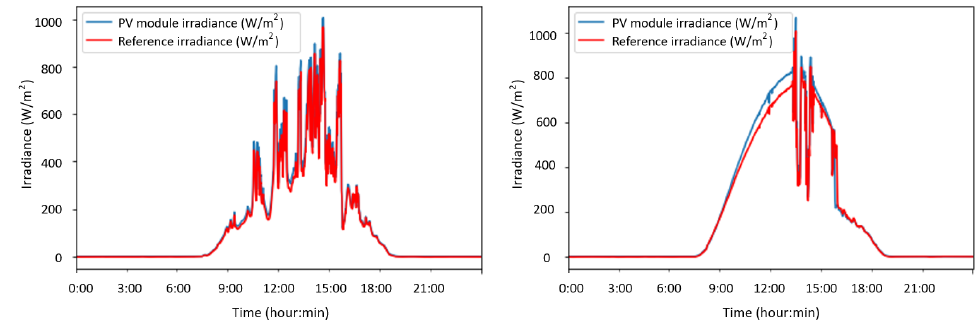
Figure 11. Calibration of the reference cell: comparison of data for two